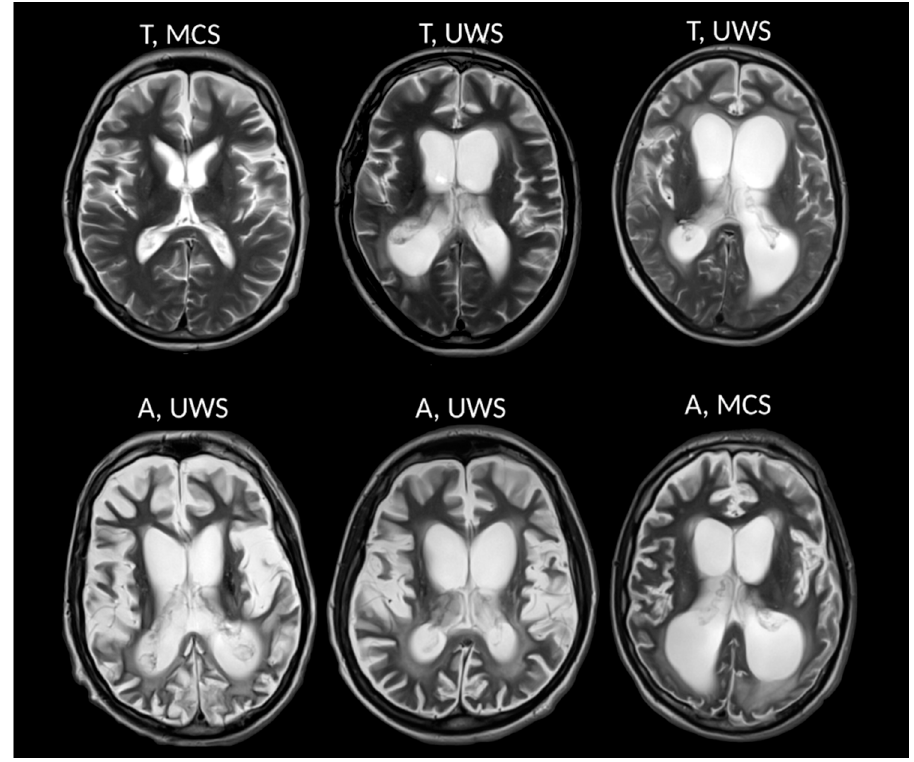
Figure 1. MRI (axial T 2 -weighted image) data present different chronic disorders of consciousness (DOC) patients from the study. Upper row—trauma patients (T), bottom row—anoxic patients (A).